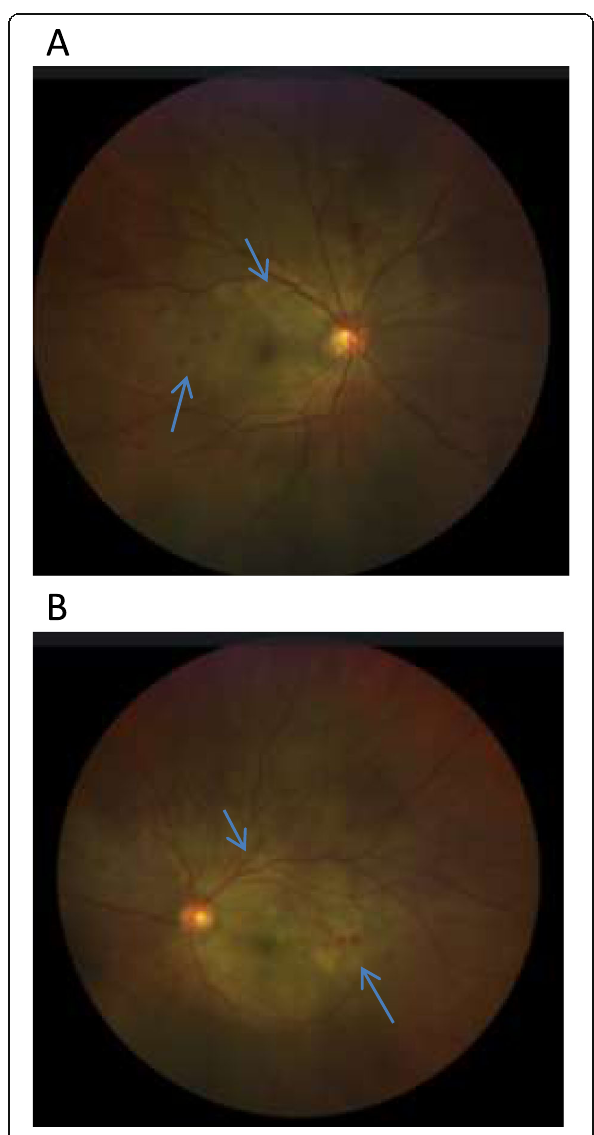
Fig. 1 a Fundus photo of the right eye with arrowheads showing areas of subretinal fluid seen superotemporally, and areas of hemorrhages seen temporal to macula. b Fundus photo of the left eye showing areas of subretinal fluid superotemporally, and areas of hemorrhages infero temporal to macula